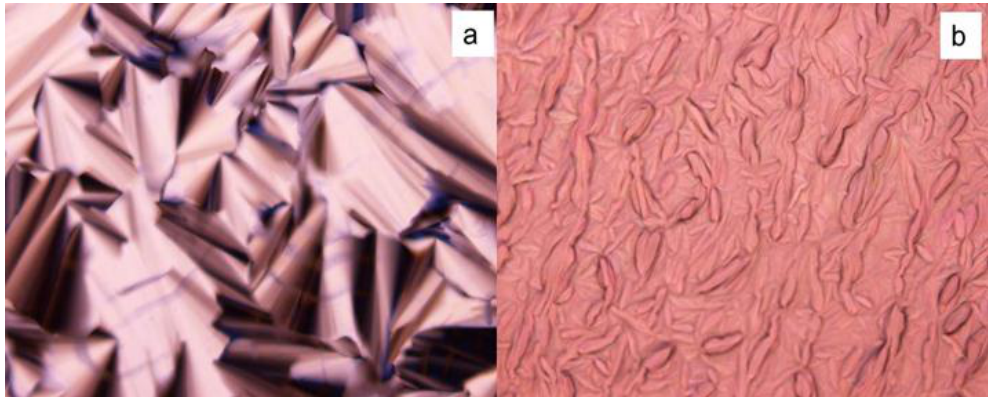
Figure 9. Polarized light microscope images before ( a ) and after ( b ) photo-polymerization. Membranes 2017 , 7 , 37